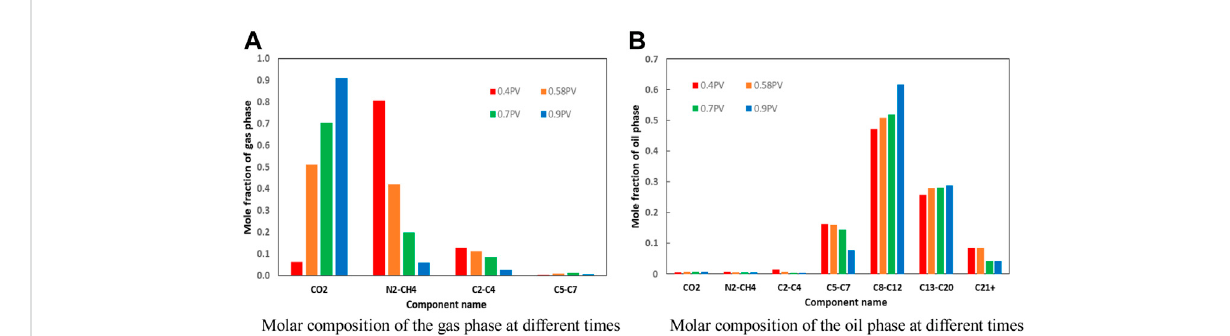
FIGURE 7 Molar composition at different times. (A) Molar composition of the gas phase at different times and (B) molar composition of the oil phase at different times.